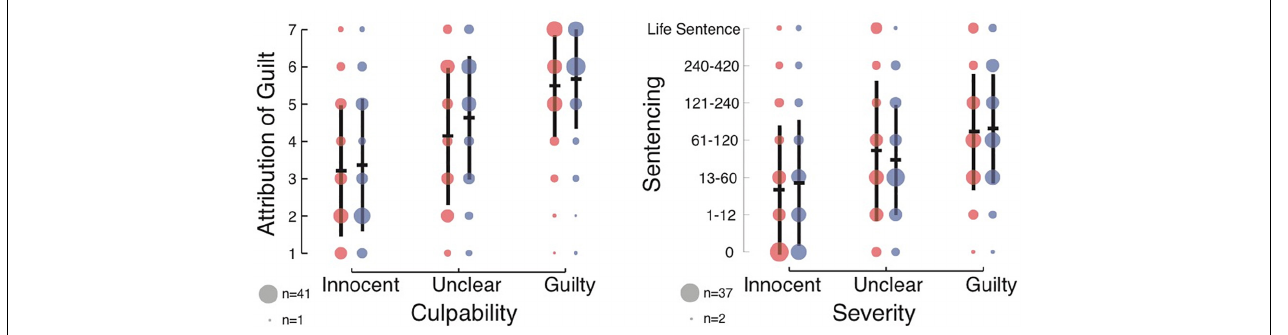
FIGURE 1 | Effect of culpability (guilty, ambiguous, and innocent) and DSF language (red for DSF and blue for non-DSF) on subjects’ attribution of defendant guilt (left), and on recommended jail sentences (right). In black, central horizontal bars depict the mean ratings given by the subjects, and vertical lines reflect the standard deviation. The radii of the circles represent the number of responses for each level in the 7-point Likert